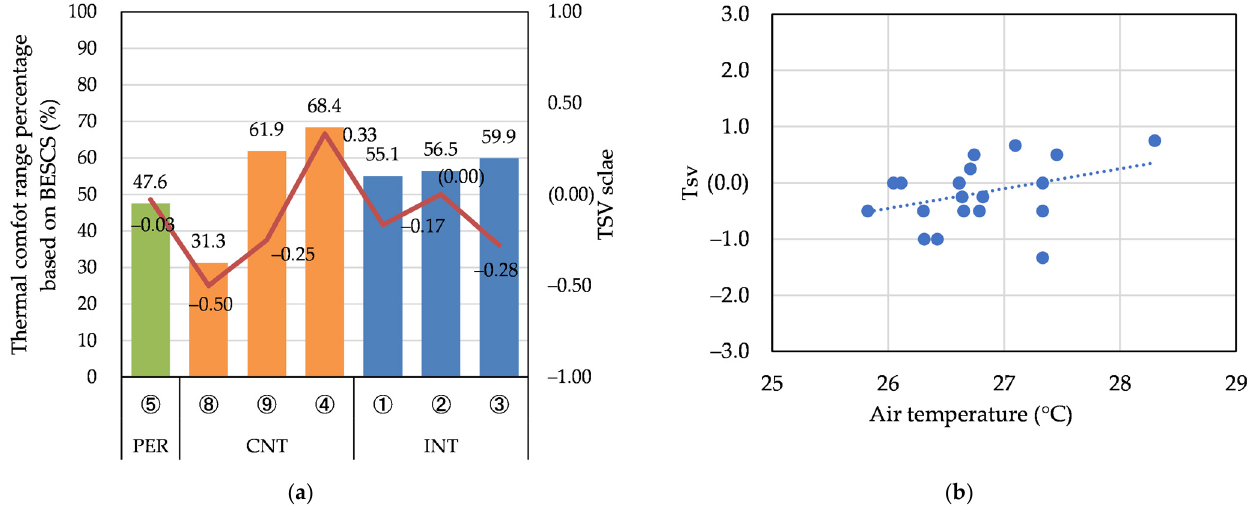
Figure 29. The correlation between field measurement result and TSV. ( a ) Indoor thermal comfort range percentage and TSV correlation. ( b ) Summer AT and TSV correlation.